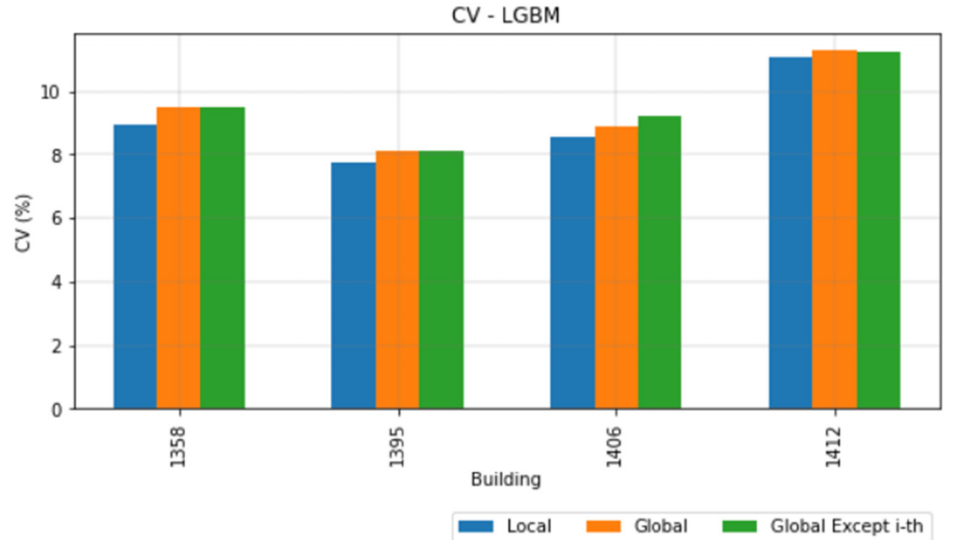
Figure 21. Comparison between the CV on test set obtained using LGBM method with different modalities: local, global and global trained using all the available data except the energy consumption related to the selected